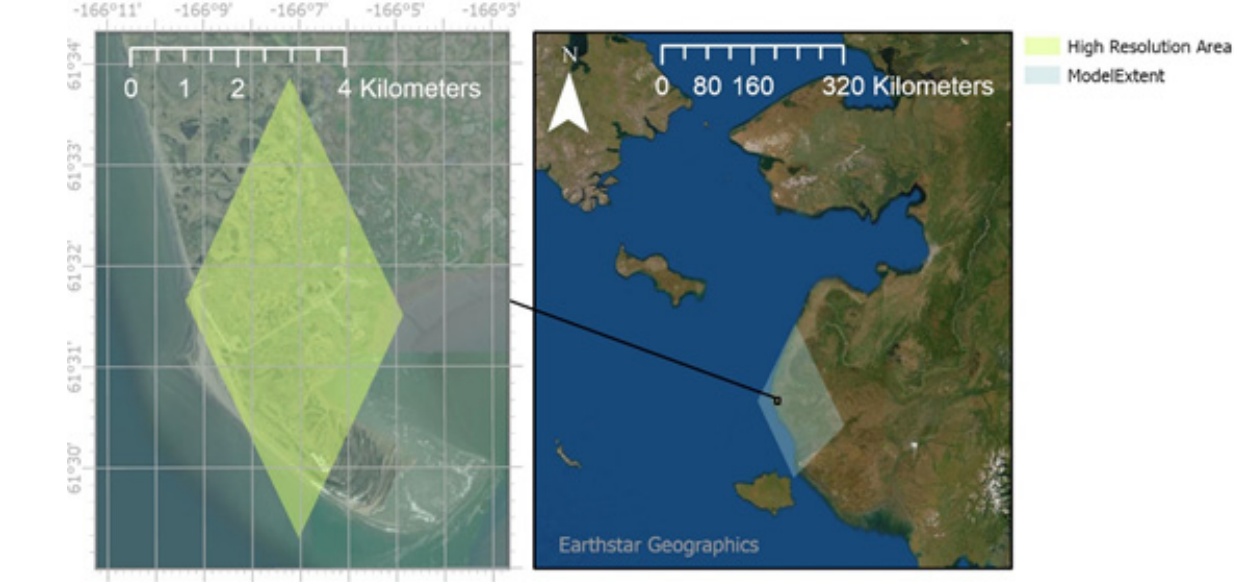
Figure 2. Delft3D model extent ( right ) and high-resolution model domain for Hooper Bay ( left ).